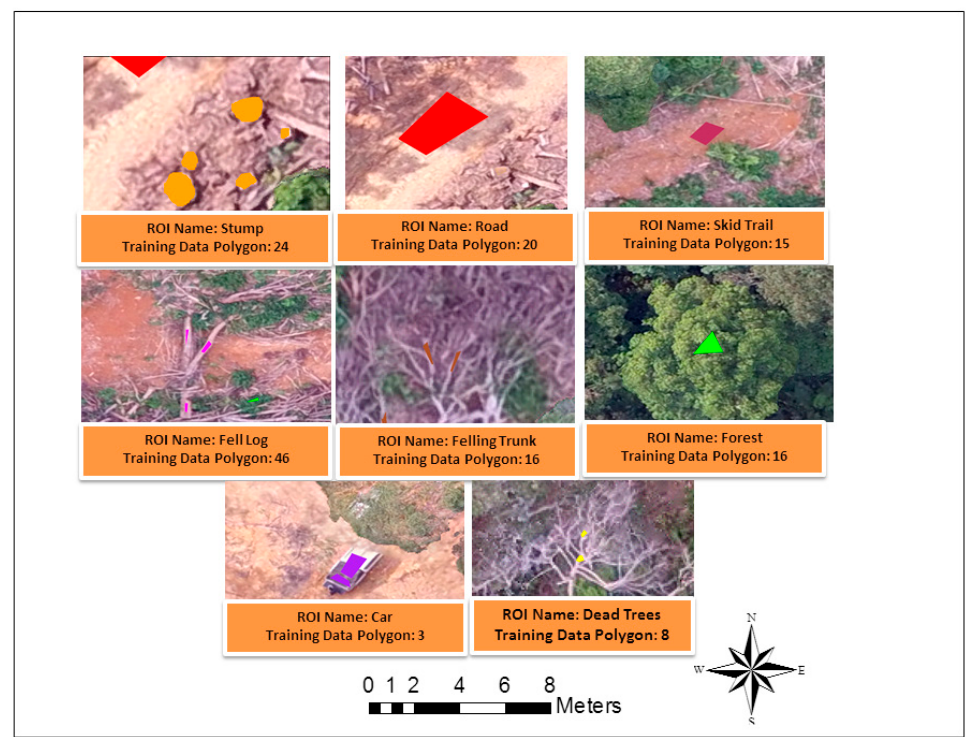
Figure 7. Collecting training samples by regions of interest that represent stump, road, skid trail, felled log, felling trunk, forest, objects (car) and dead trees in Ulu Jelai forest.